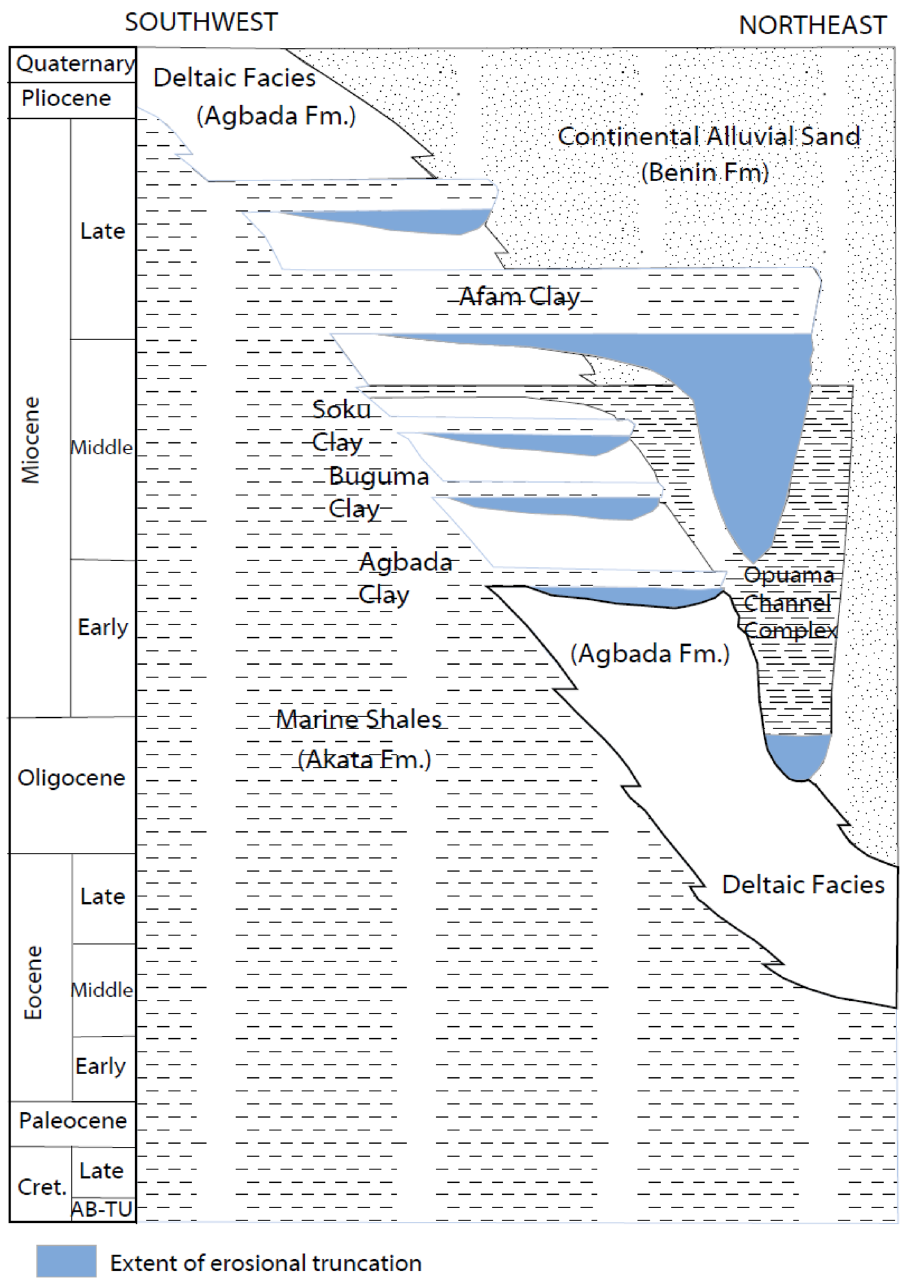
Fig. 3 Stratigraphic column showing the three formations of the Niger Delta. Shannon and Naylor (1989) and Doust and Omatsola